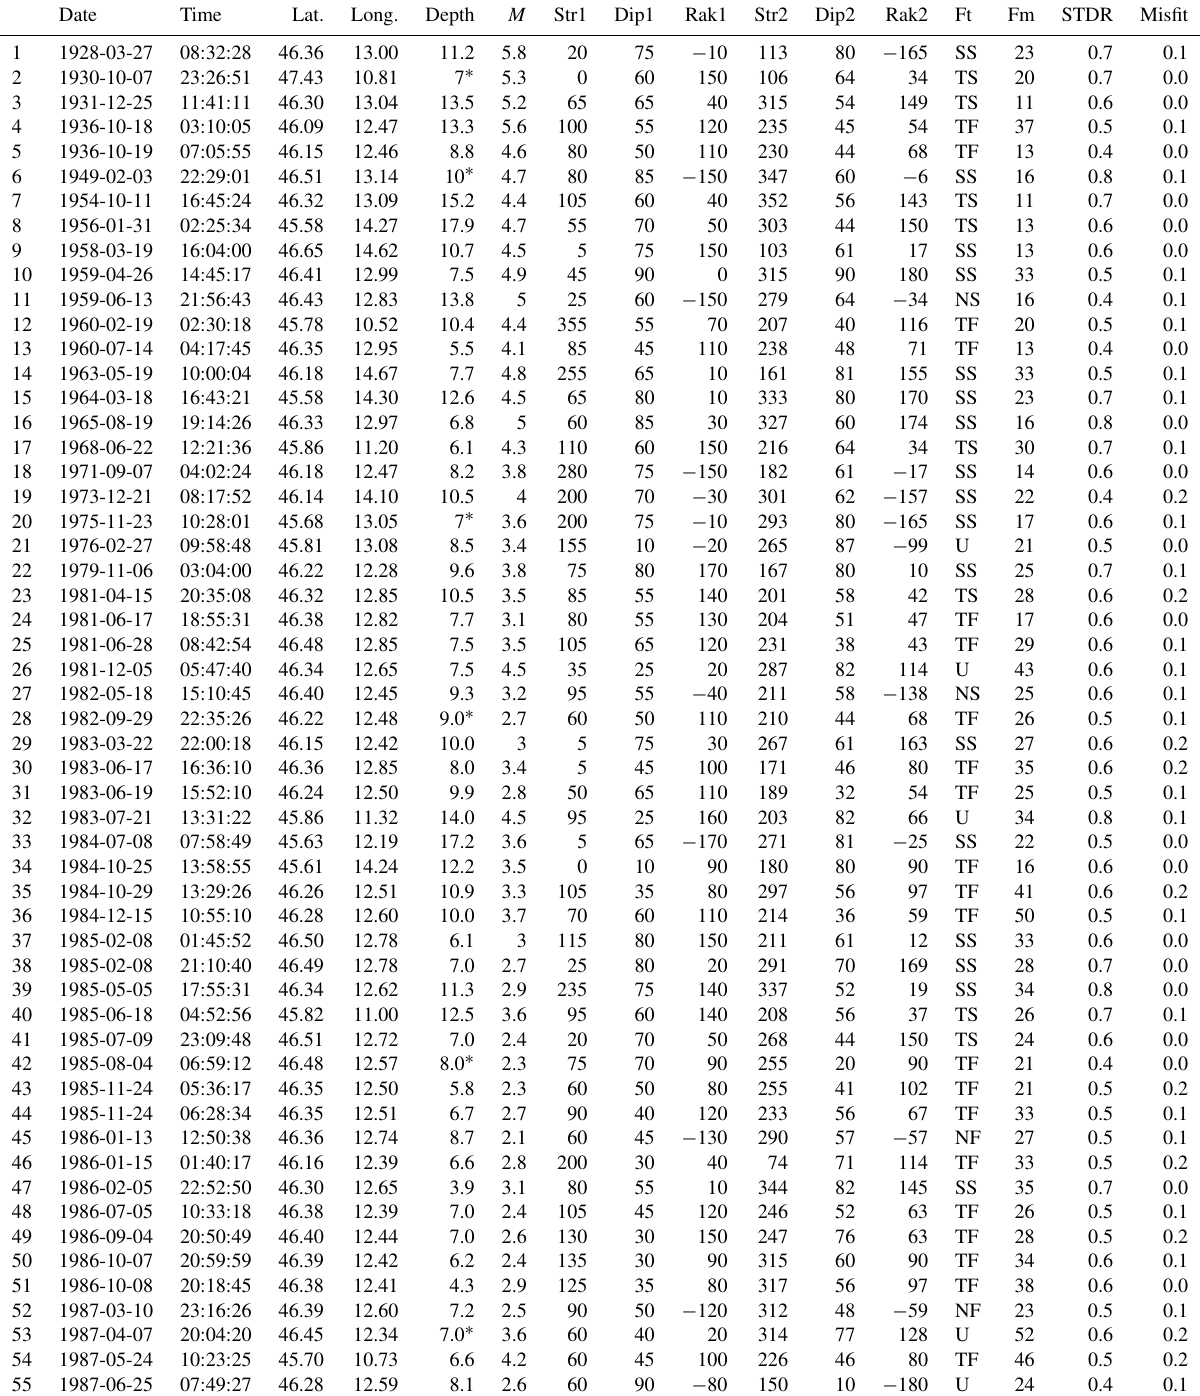
Table 1. Parameters of the new FPSs computed by first-motion polarities (Sugan et al., 2020). Here we report the following: date (yyyy- mm-dd), time (hh:mm:ss), lat. (latitude north in degrees) and long. (longitude east in degrees), depth (km; ∗ indicates fixed), M (magnitude), Str1, Dip1, and Rak1 (strike, dip, and rake of the first fault plane in degrees), Str2, Dip2, and Rak2 (strike, dip, and rake of the second fault plane in degrees), Ft (fault type according to Zoback, 1992), Fm (number of first-motion polarities), STDR (station distribution ratio), and misfit. Other details are given in the full catalogue (Supplement and Saraò et al.,